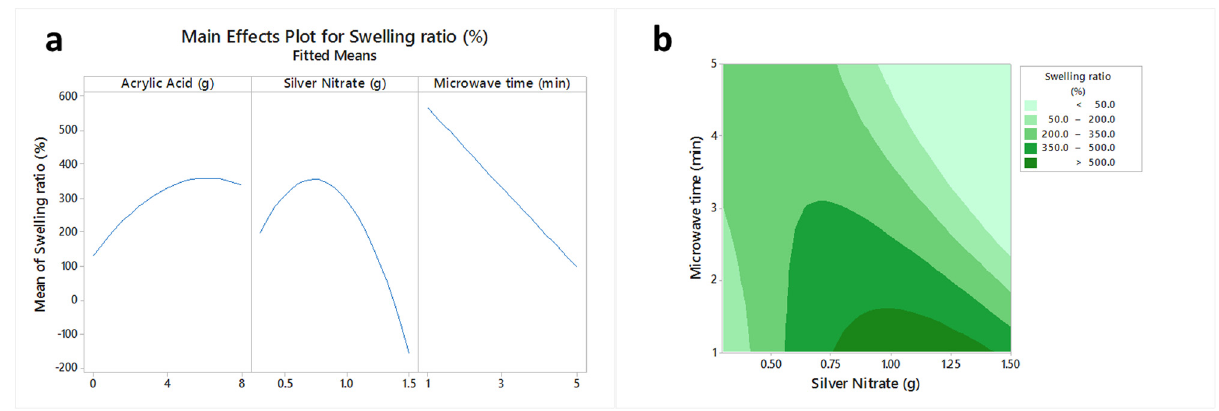
Figure 1: The main e ff ects plot ( a ) and the contour plot ( b ) of acrylate acid, silver nitrate and microwave time on swelling ratio of sodium alginate/acrylic acid composite hydrogels conjugated to silver